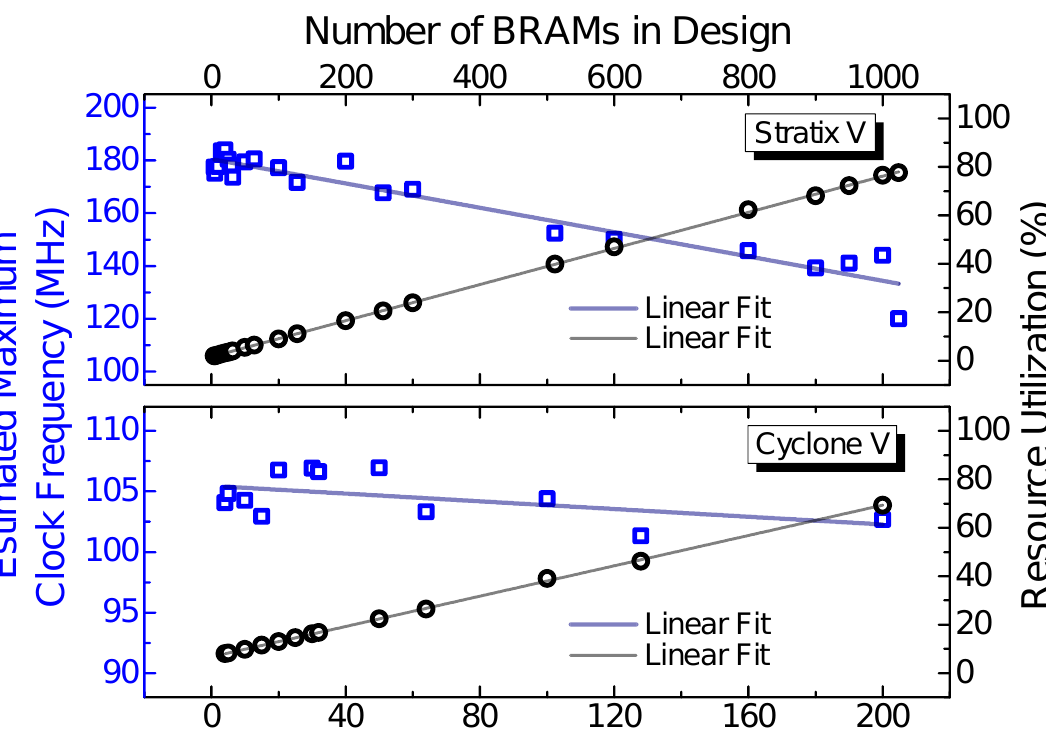
Figure 6. Resource and timing analysis for two FPGA chips of different sizes: the smaller C YCLONE V; and the mid-range S TRATIX V. These results correspond to the optimal place-and-route procedure of commercially available hardware-design software, namely the Q UARTUS P RIME